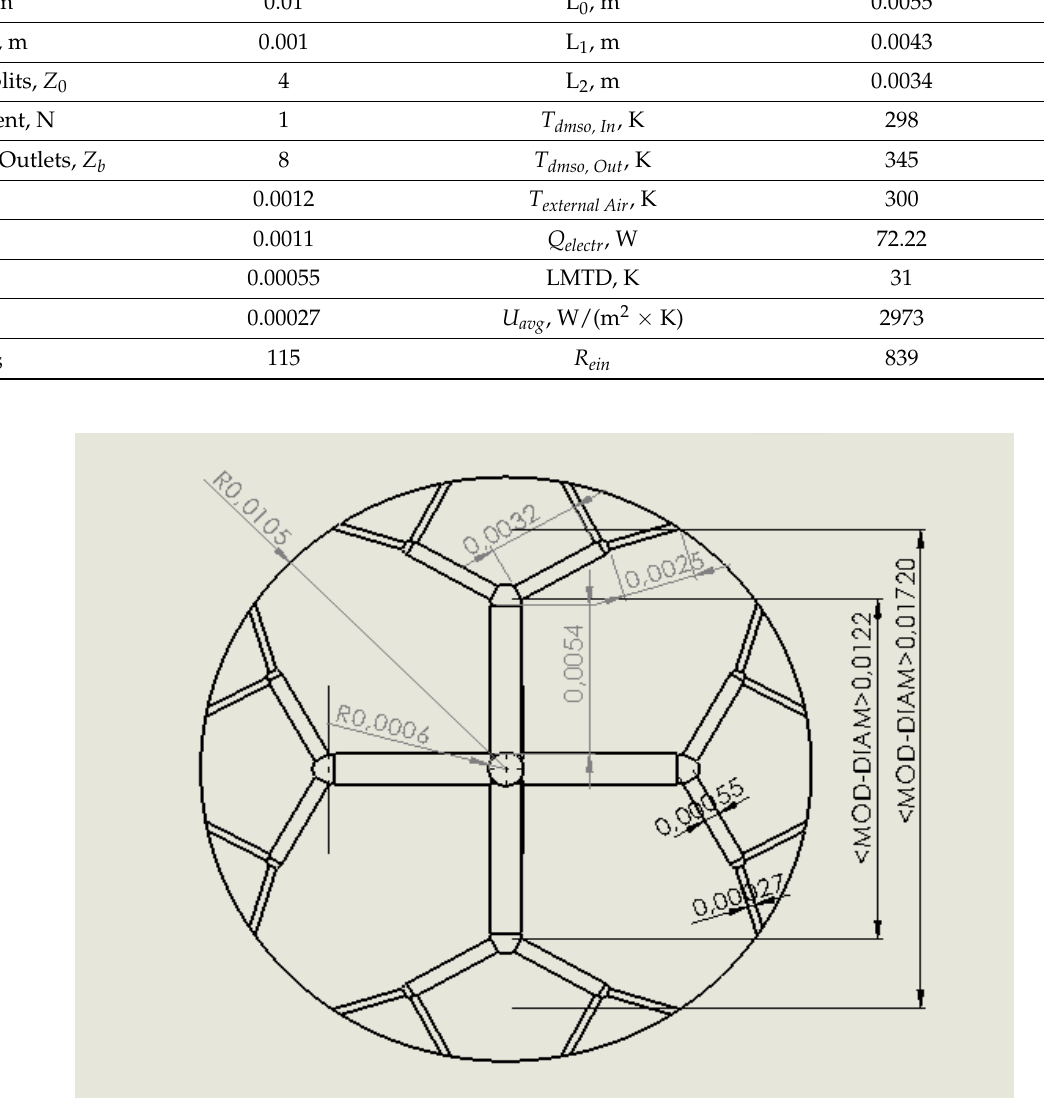
Figure 10. The improved ultra-micro DSHE-C2.